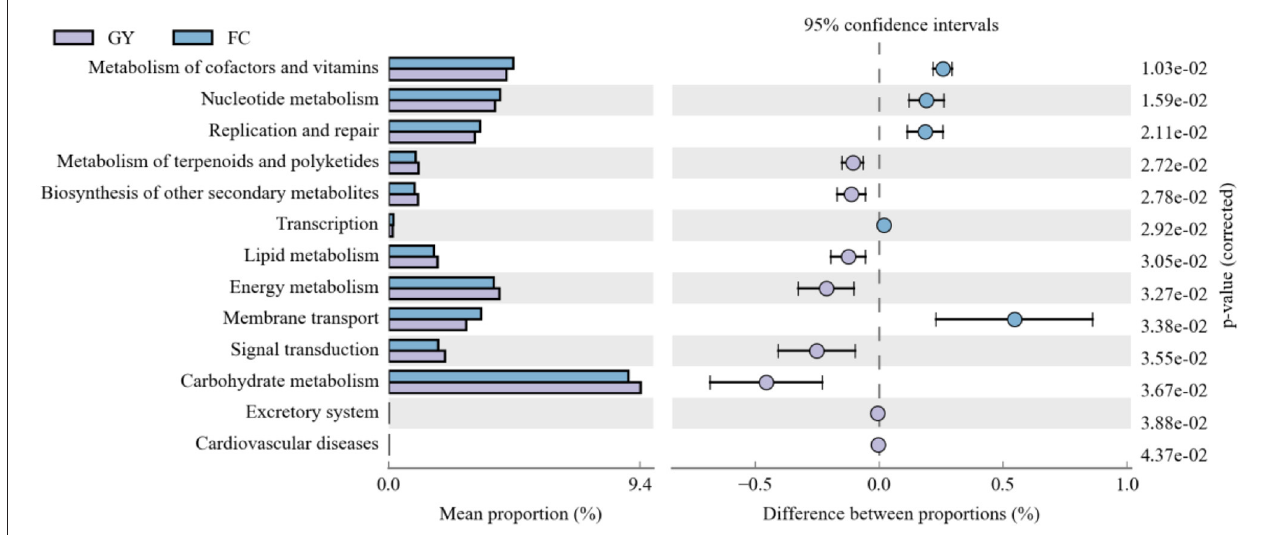
FIGURE 6 | Kyoto Encyclopedia of Genes and Genomes (KEGG) analysis of rumen bacteria between GYs and FC.